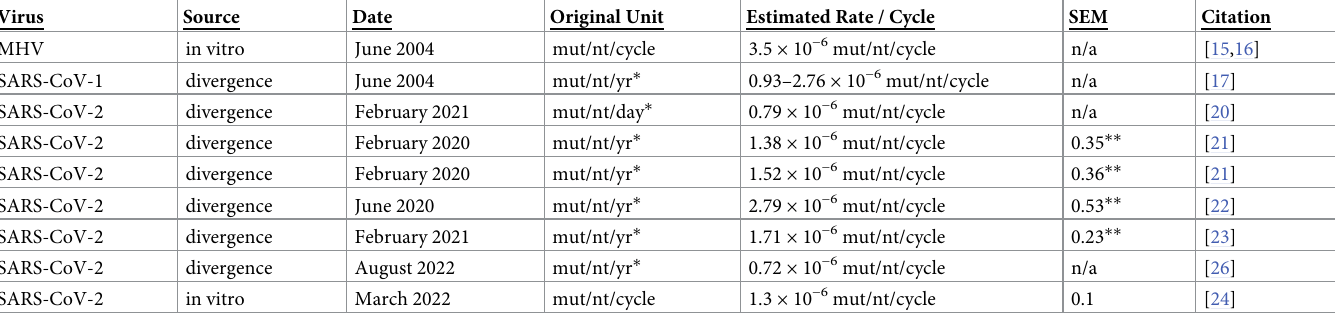
Table 1. Estimated mutation rates in SARS-CoV-2, and the related CoV-1 and MHV.